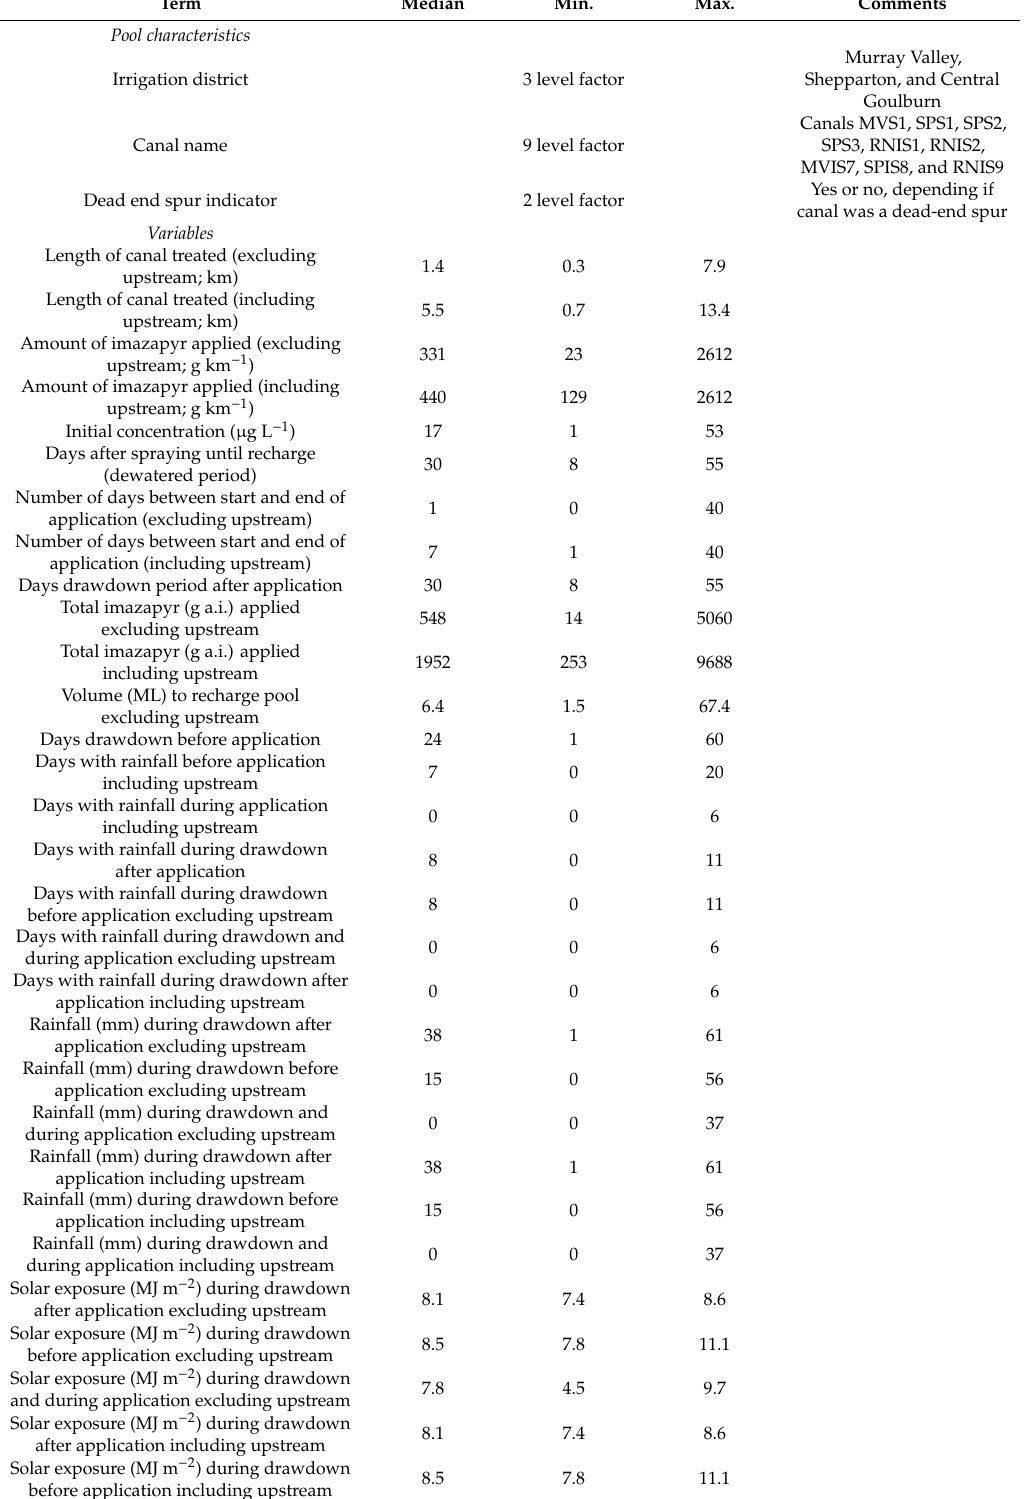
Table 2. Terms assessed for inclusion in the model for predicting the ratio of the first imazapyr concentration recorded after the start of ponding to the amount of imazapyr applied per km of